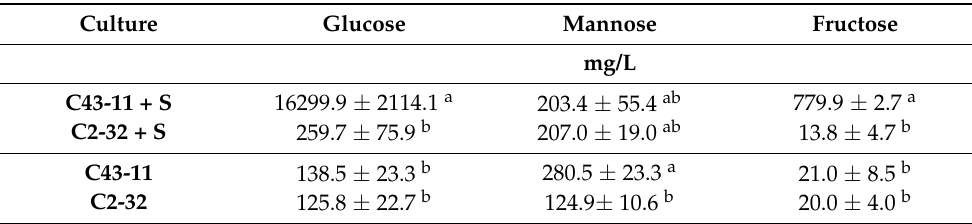
Table 2. Glucose, mannose, and fructose (mg/L) produced by strains C43-11 and C2-32 in mMRS + S and mMRS bacterial cultures after quantified analysis by